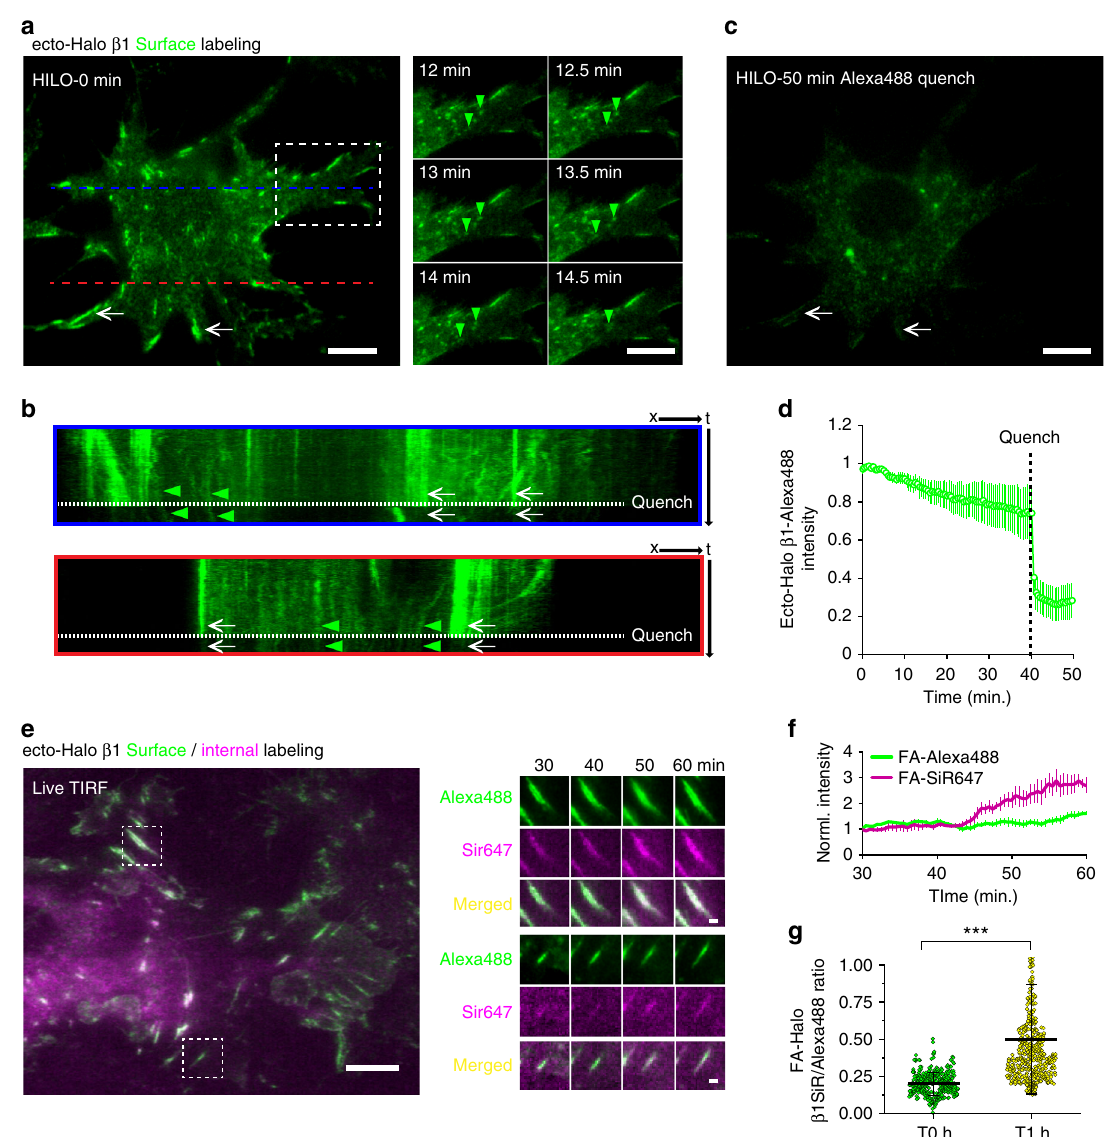
Fig. 7 Selective surface and internal labeling of ecto-Halo β 1 integrins demonstrates integrin endocytosis in live cells. a Labeling of surface ecto-Halo β 1 integrins in reconstituted KO fi broblasts with Alexa488 Halo ligand and imaging by HILO TIRFM immediately after labeling (0 min). Scale bar , 15 µ m. Right panel , movement of Alexa488-positive vesicle-like structures ( dashed line rectangle , green arrowheads ). Scale bar , 10 µ m. b Kymograph of two regions of the cell ( blue and red lines ) illustrating the dynamics of Alexa488-positive structures before ( green arrowheads ) and after the addition of Alexa488 quencher antibody ( white arrows ). c Residual Alexa488 signal after quenching, imaged by HILO TIRFM 50 min post labeling ( white arrows ). Scale bar , 15 µ m. d quanti fi cation of normalized ecto-Halo β 1 Alexa488 intensity before and after quenching. The line graph shows the mean ± SD of the normalized intensity for 5 cells. e Overlay image of KO fi broblasts reconstituted with ecto-Halo β 1 integrins, after sequential labeling with Alexa488 and SiR647 Halo ligands and imaged by TIRFM. Scale bar , 15 µ m. Images on the right show the time series of two FAs ( dashed line square ). Scale bar , 2.5 µ m. f Line graph showing the temporal changes in SiR647 and Alexa488 Halo signals in FAs measured by TIRFM during a 30 min period (mean ± SD for 4 FAs). g Scatter-box graph showing the mean ± SD for the ratio of SiR647/Alexa488 Halo signals of 388 and 523 FAs imaged by TIRFM 0 h or 1 h after incubation at 37 °C on fi xed samples (6 cells per conditions). Statistical analysis was performed using a two samples Student ’ s t -test and *** p < over time (Fig. 5e, yellow lines ), and (3) the average vesicular are effective in different cell types and can be applied even in the pro fi le of multiple fusion events (n = 44 – 67), which were time- presence of endogenous β 1 integrin. Photobleaching of the aligned to fusion, showed the expected intensity spread during background surface signal (Supplementary Fig. 4) allowed us to exocytosis 43 (Fig. 5f). Notably, this approach allowed us to visualize for the fi rst time pHluorin- β 1 integrin exocytosis events visualize pHluorin- β 1 integrin exocytosis events, which appeared (Fig. 5a, b, green label ; Supplementary Movies 1 – 2). Critically, to occur preferentially near FAs (Fig. 5a, b, dashed line square ; pHluorin- β 1 integrin cargo incorporated and dispersed into the inset). plasma membrane in a manner that shows a clear signature of exocytic fusion 43 : (1) a rapid increase in signal when a pHluorin cargo-loaded vesicle de-acidi fi ed (Fig. 5c, d; yellow circles ), (2) the full-width half maximum (FWHM) of the signal peak increased